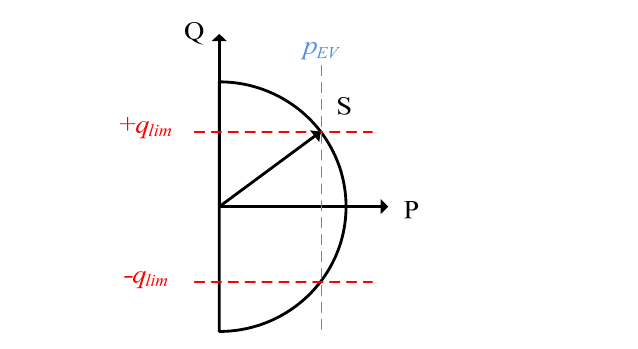
Figure 2. Reactive power generation limit [32].